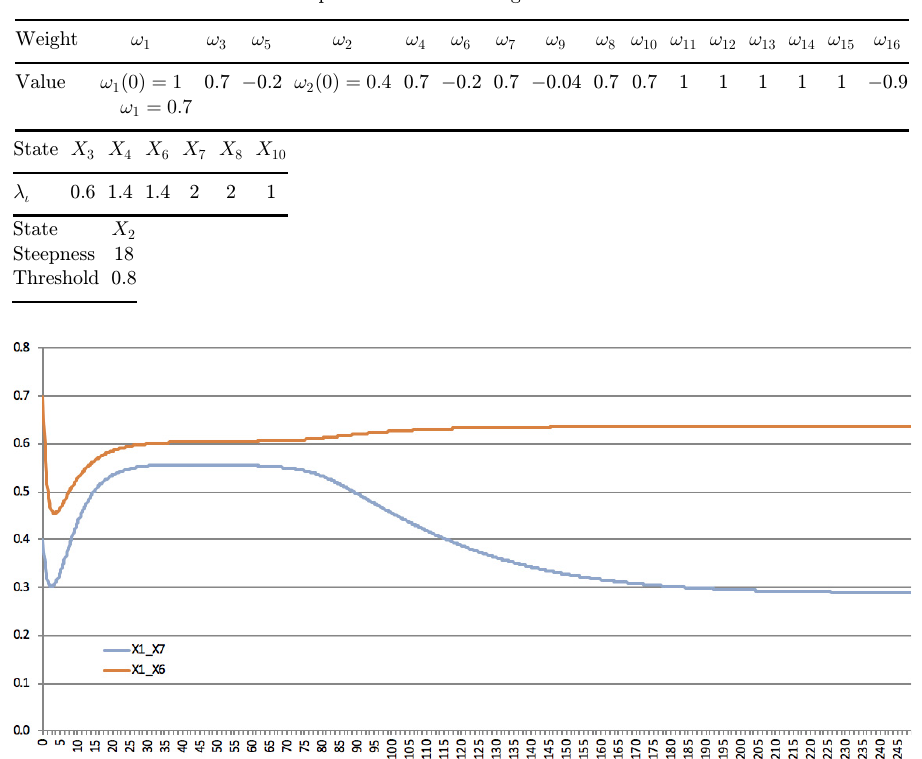
Fig. 9. Simulation results for suppression and Hebbian learning for ! 1 (connection X 1 – X 6 ) and ! 2 (connection X 1 – X 6 ) with having extreme emotion at the beginning (Scenario